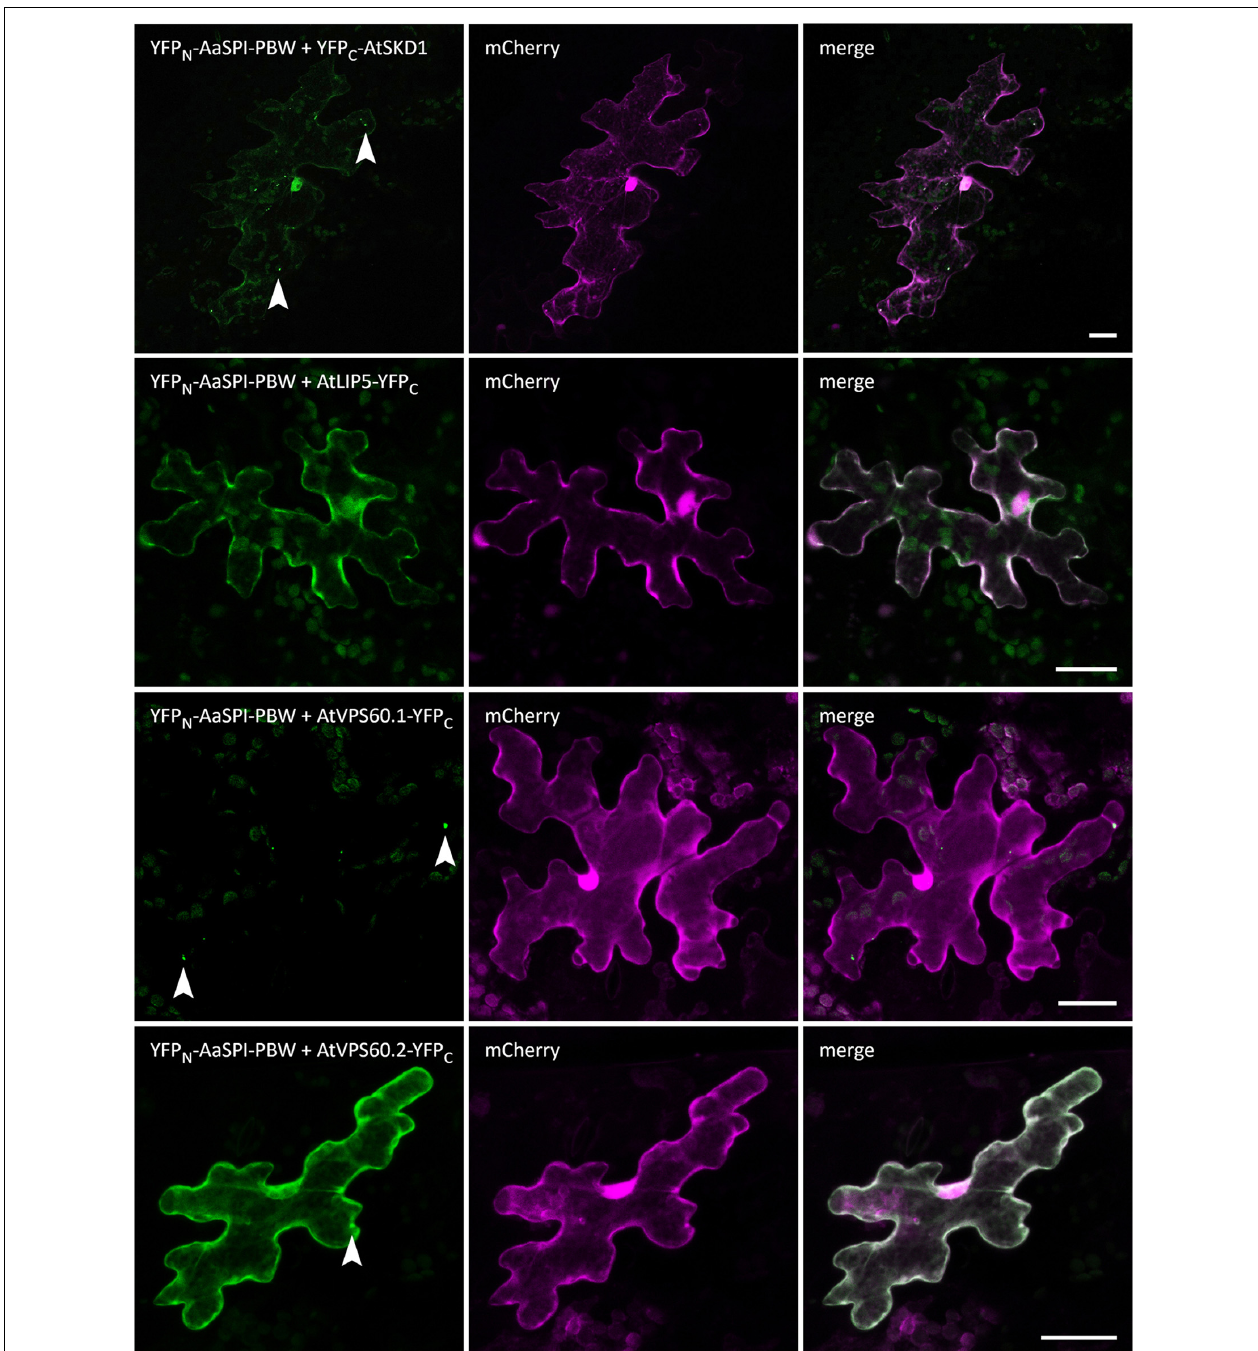
FIGURE 6 | BiFC interactions of AaSPI-PBW with ESCRT components AtSKD1, AtLIP5, AtVPS60.1, and AtVPS60.2. Left—BiFC, middle—transformation control, right—overlay of BiFC and transformation control. Arrow heads indicate sites of interaction. Scale bars: 25 µ m.